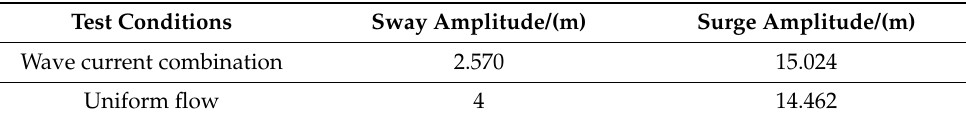
Table 2. Results of wave current joint model